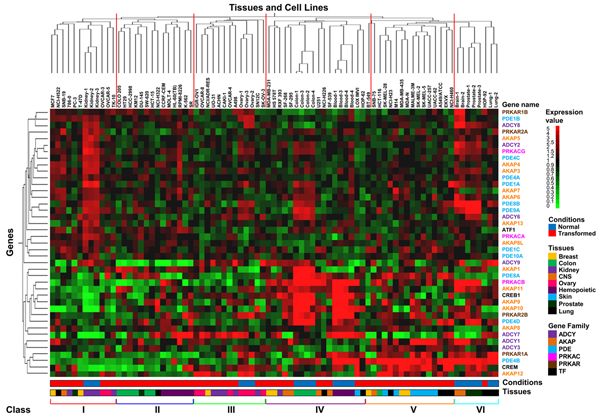
Hierarchical clustering of the 41 PKA pathway-encoding genes analyzed in this paper. Two-way (gene, column and cell line, row) hierarchical clustering (see Methods) of the same profiles analyzed in Figure 1. Normalized expression is colour-coded from green (poor expression) to red (strong expression). The name of each gene is colour-coded according to family to which it belongs.The 6 main classes described in the text (red lines on the top of the dendrogram and roman number bottom of the dendrogram) are shown. The distance function is based on Pearson correlation and complete linkage clustering. Legends for expression, condition, gene family and tissue of origin are shown on the right of the dendrogram.